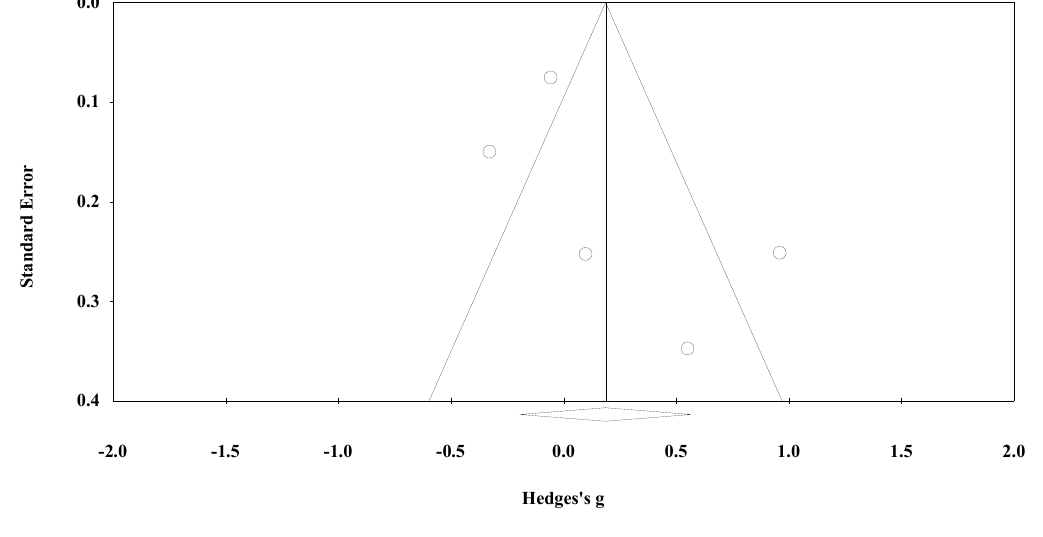
Note. k = 5; The diamond represents the average effect size (Hedges’s g).